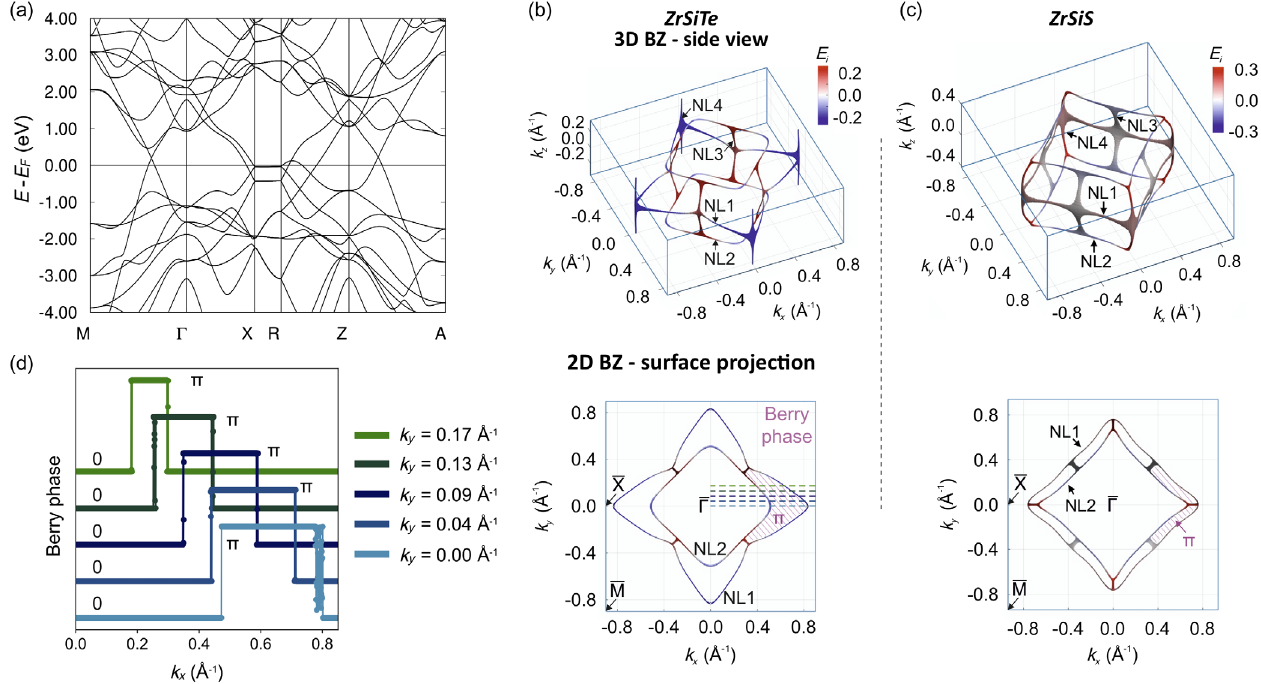
FIG. 2. (a) Bulk band structure of ZrSiTe without SOC. (b) ZrSiTe nodal line connectivity in the 3D BZ (top) and (001) surface projection (bottom). The area of the calculated π Berry phase is indicated in purple in one quadrant. (c) Nodal line connectivity of ZrSiS analogous to panel (b). (d) Berry phase calculated from Wilson loops along k z as a function of k x for fixed k y . A Berry phase of π implies the presence of topological drumhead surface states at the (001) surface. The constant k y cuts correspond to the dashed lines in panel